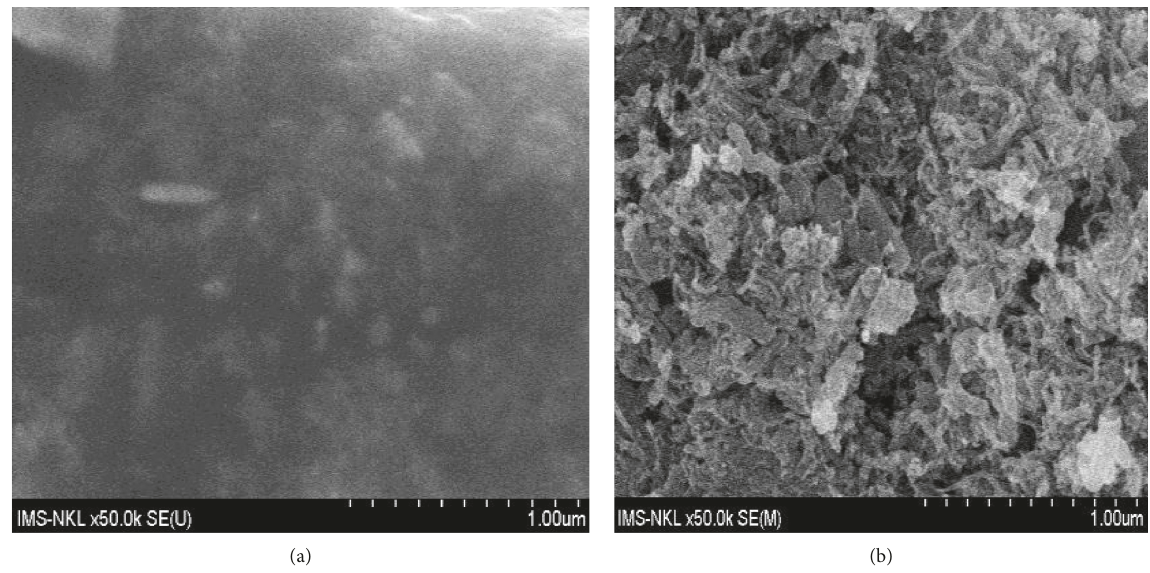
Figure 5: Scanning electron micrographs of the CPE modified with 5% Bi 2 O 3 (w/w) (a) before and (b) after electrochemical reduction at − 1.2V for 120s in the supporting electrolyte mixture of 0.1M KI and acetate buffer solution. Other conditions are as in Figure 1.